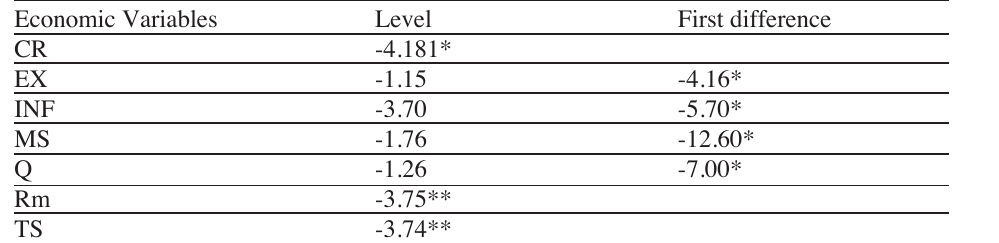
Note: Unit Root test conducted on level at trend and on 1st difference at trend and